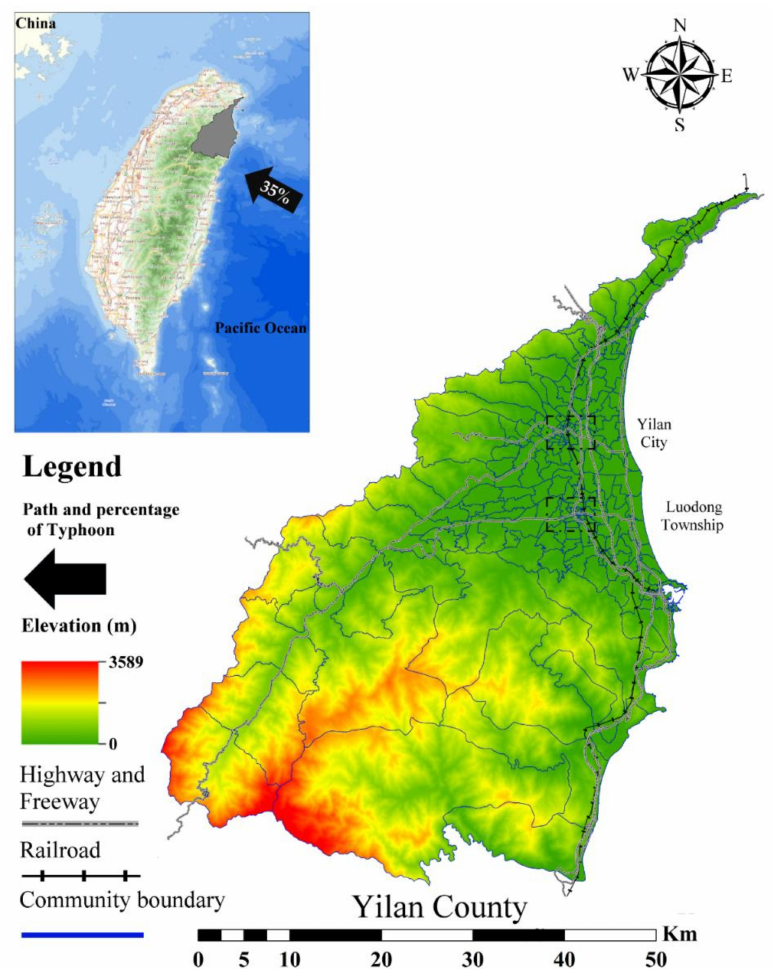
Figure 1. The study site, Yilan County, is located in northeastern Taiwan. Yilan City and Luodong Township are the major urban areas in our study site. Owing to the location of Yilan County, over 30% of the typhoons striking Taiwan will have a direct impact on our study